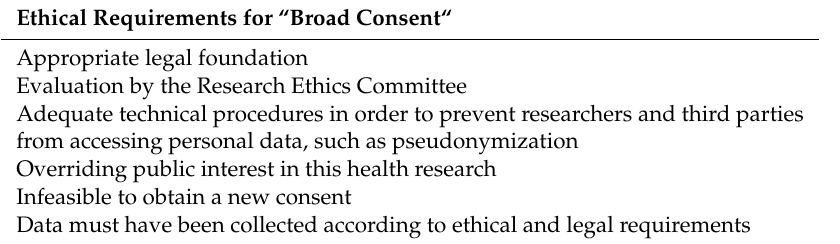
Table 3. Ethical requirements for secondary analysis of data, without a new informed consent 1